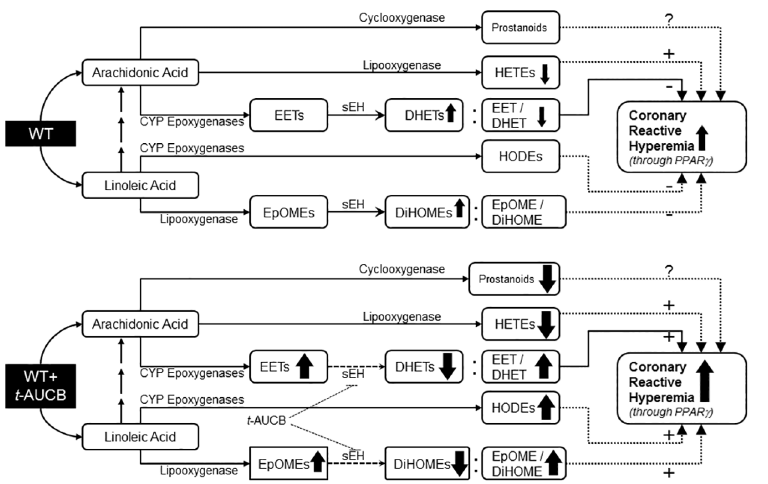
Fig 12. A schematic diagram comparing the oxylipin changes observed in response to a brief ischemia and their possible impact on coronary reactive hyperemia (CRH) between WT and t -AUCB- treated WT mice. Treatment with t -AUCB enhanced CRH possibly through increased EET/DHET ratio, increased 13-HODE, increased EpOME/DiHOME ratio, decreased mid-chain HETEs, and PPAR γ